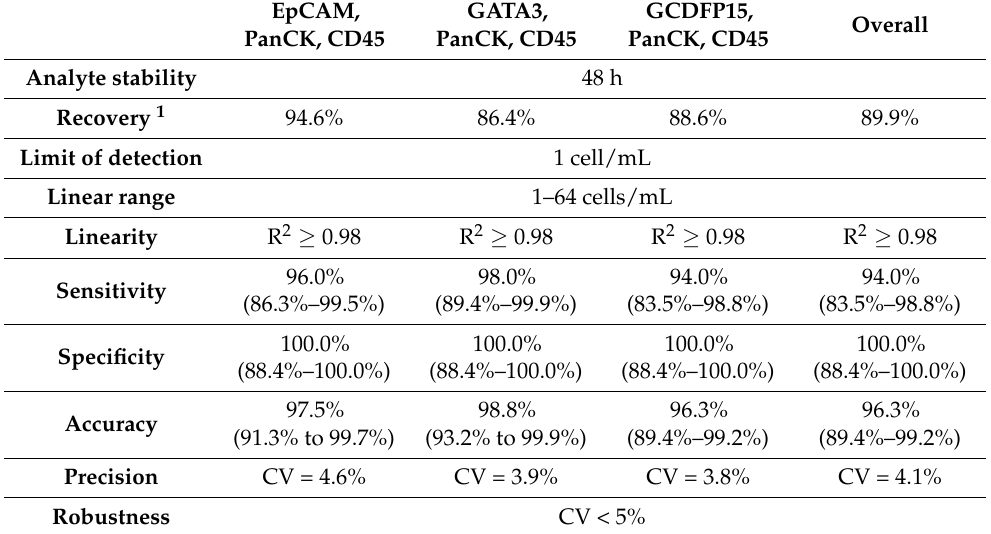
Table 1. Summary of analytical validation studies. The summary of findings of the analytical validation studies indicate that the rest provides consistent, accurate, and reproducible results, with little or no interference from routine endogenous or exogenous factors when samples are obtained, stored, and processed under the recommended